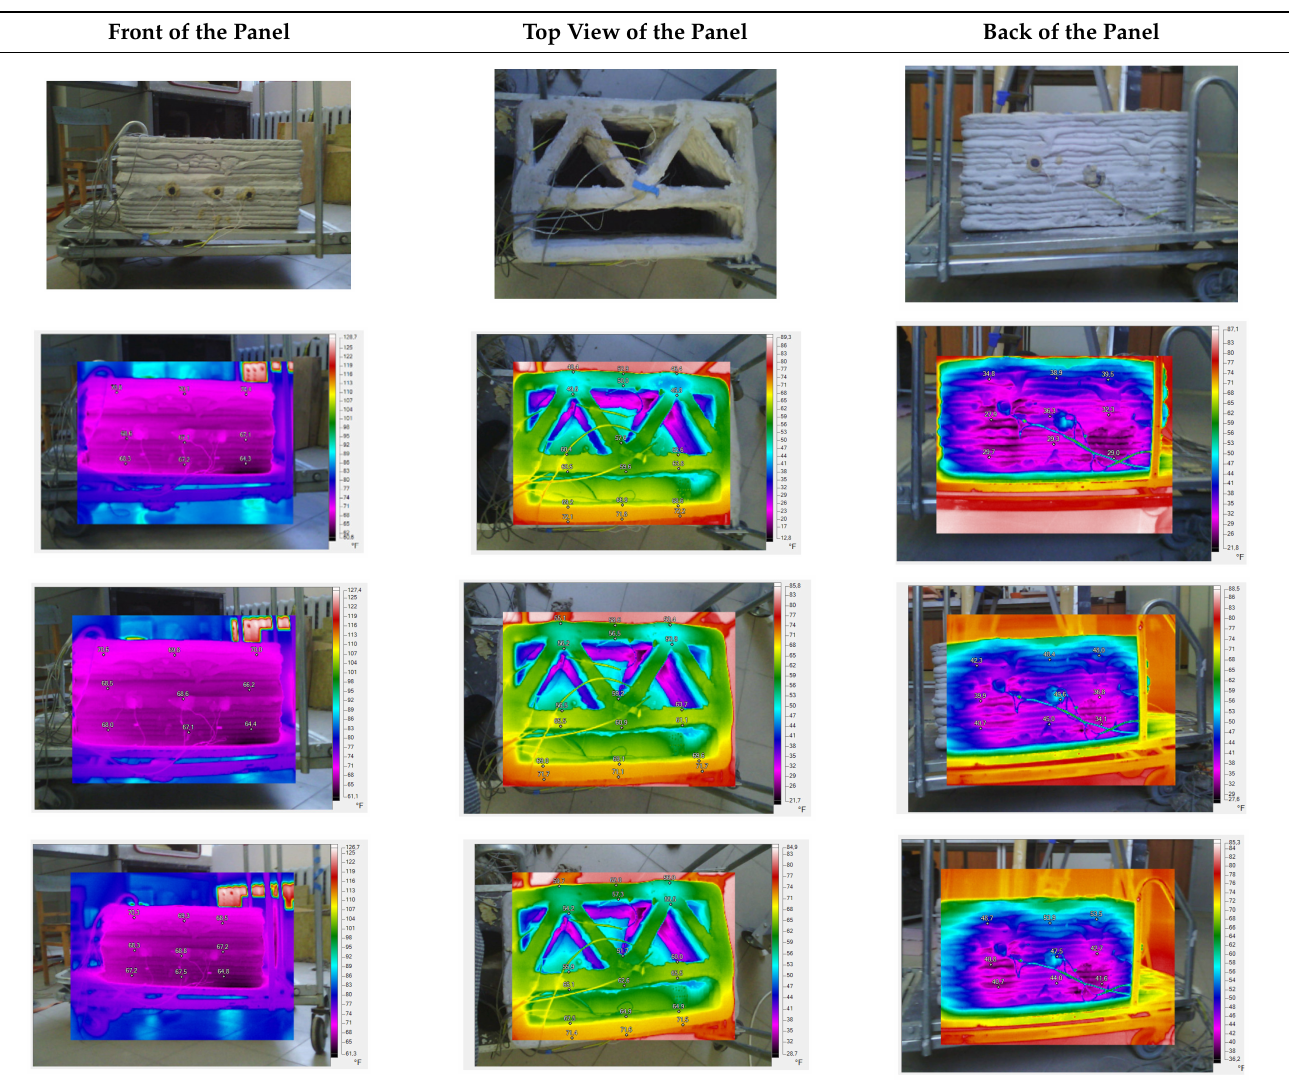
Table 10. Thermal imaging